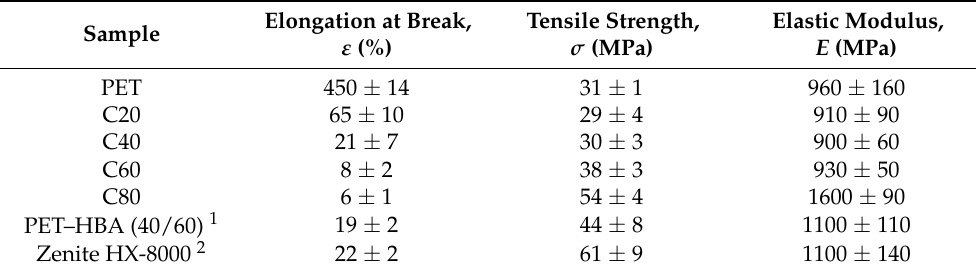
Table 7. Mechanical characteristics of C20–C80 copolyester films in comparison with PET, and other similar previously described copolyesters. The average film thickness was 0.17 ± 0.03 mm for all